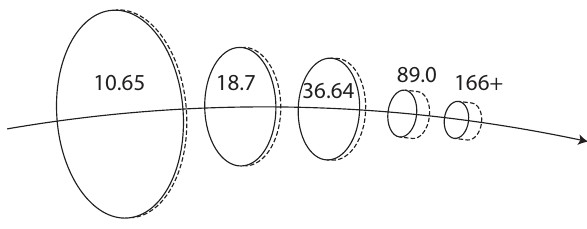
Figure 3. Schematic depiction of the difference between the instan- taneous field of view (IFOV; solid lines) and the effective field of view (EFOV; dashed lines) for different channels of the GMI, as measured at the half-power points of the effective antenna func-